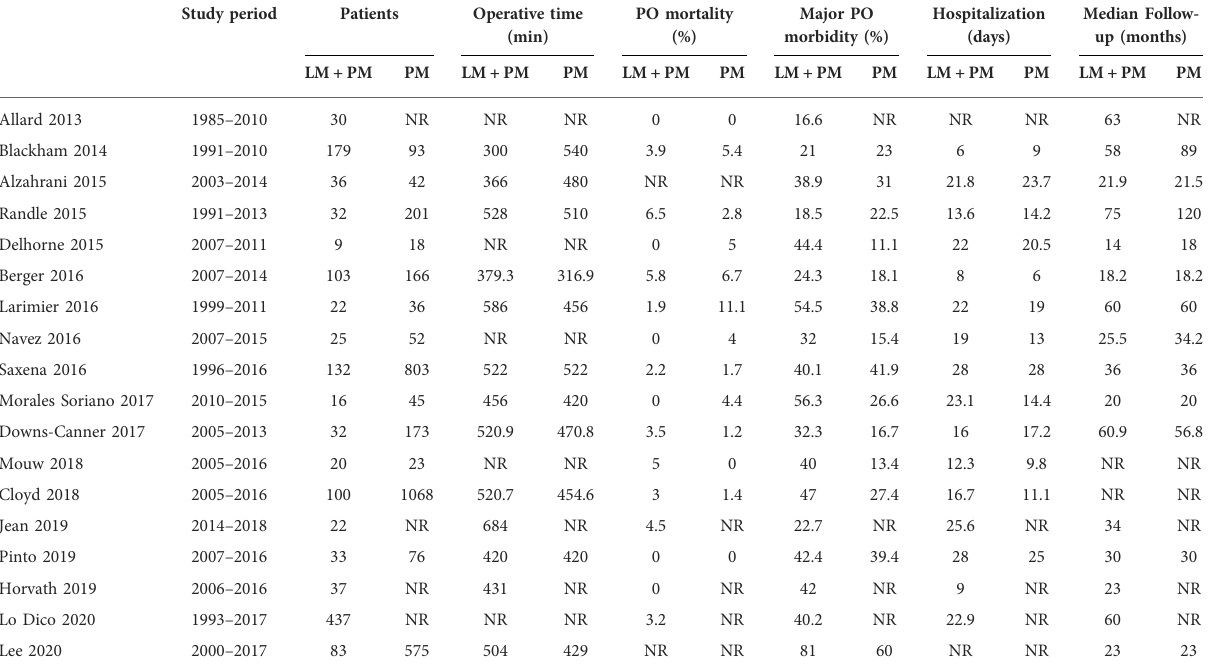
TABLE 1 Surgical outcomes of available literature